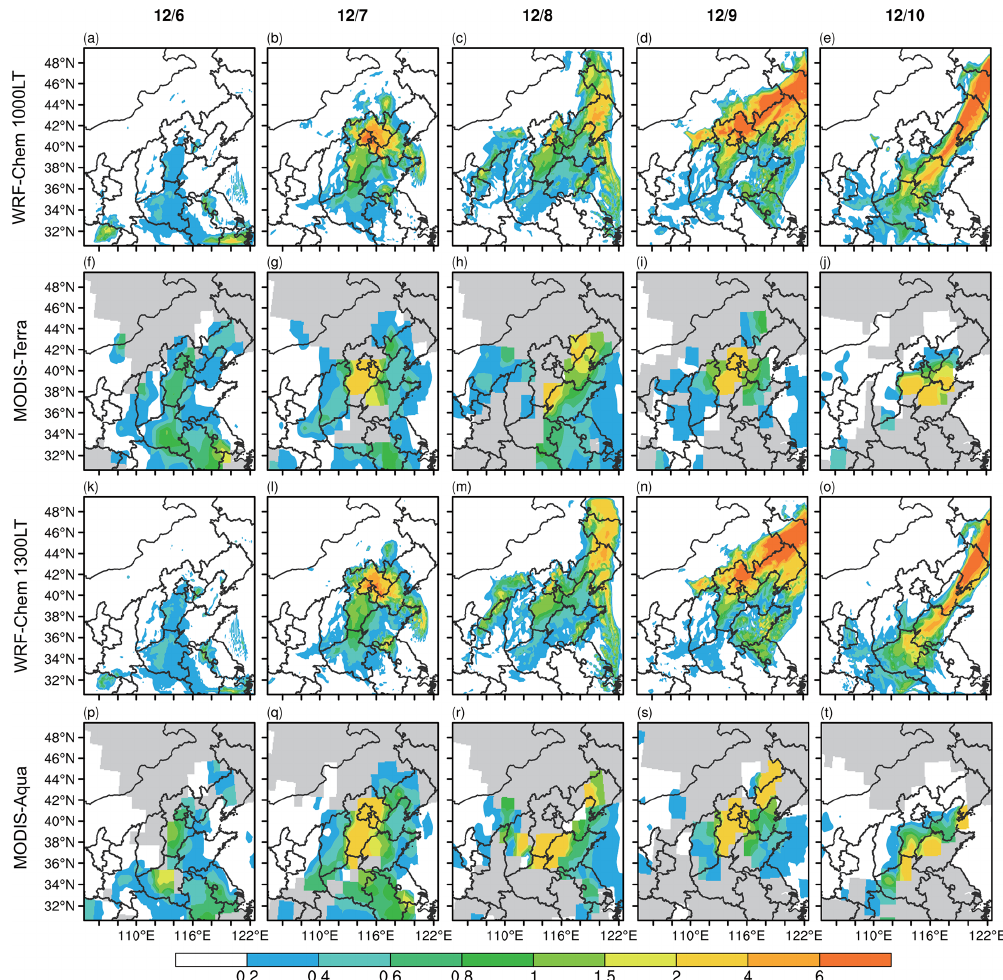
Figure 2. The WRF-Chem simulated and MODIS observed spatial distribution of AOD on 6–10 December (from left to right). The first (a–e) and third rows (k–o) are WRF-Chem simulations at 10:00 and 13:00LT (MODIS path times) respectively. The second (f–j) and fourth (p–t) rows are MODIS Terra and Aqua observations, respectively. Gray areas in (f–j) and (p–t) denote the missing